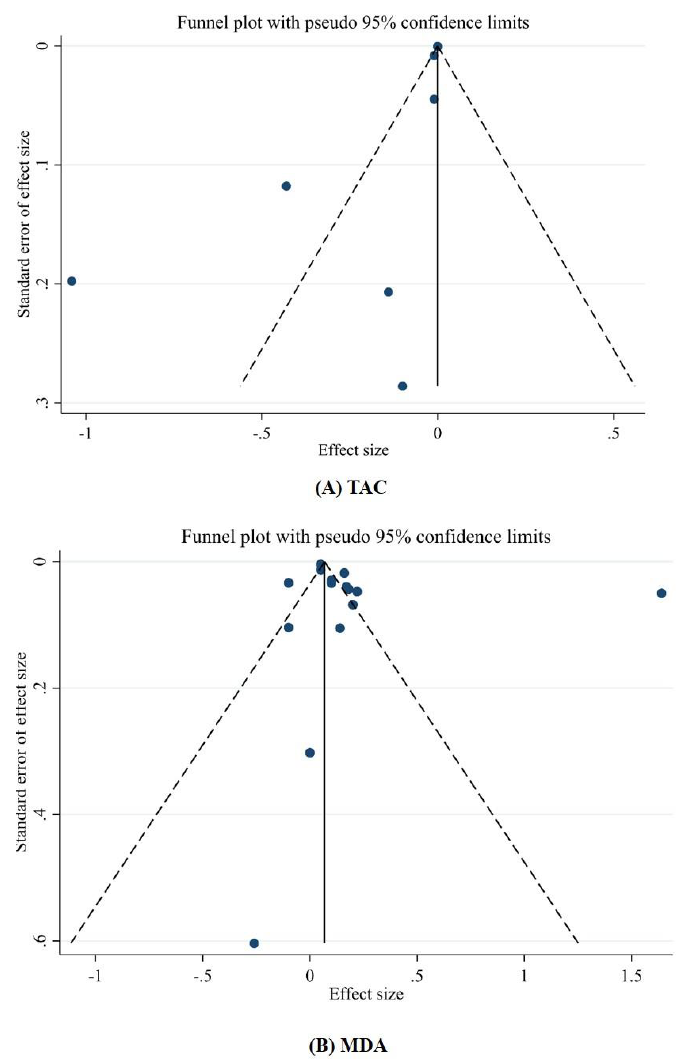
Figure 3. Funnel plot for the effect of green tea consumption on; ( A ) TAC; ( B ) MDA.